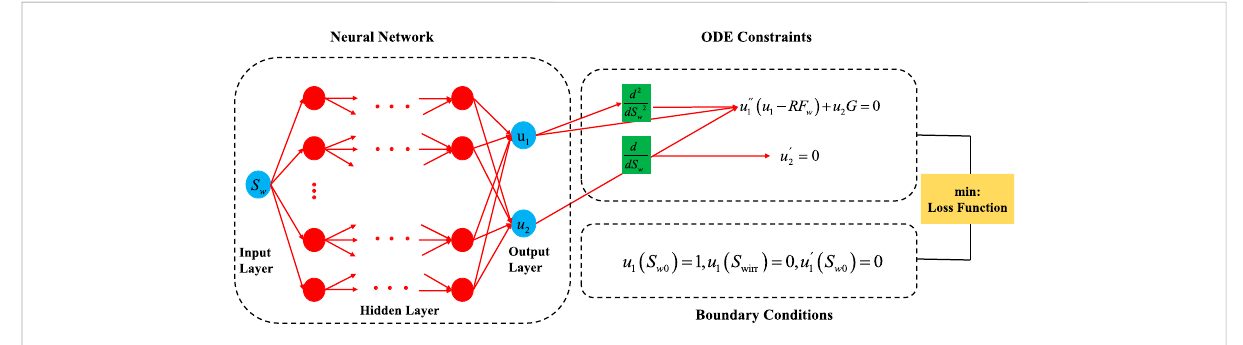
FIGURE 2 PINN con fi guration for transient spontaneous imbibition solutions (Deng and Pan,